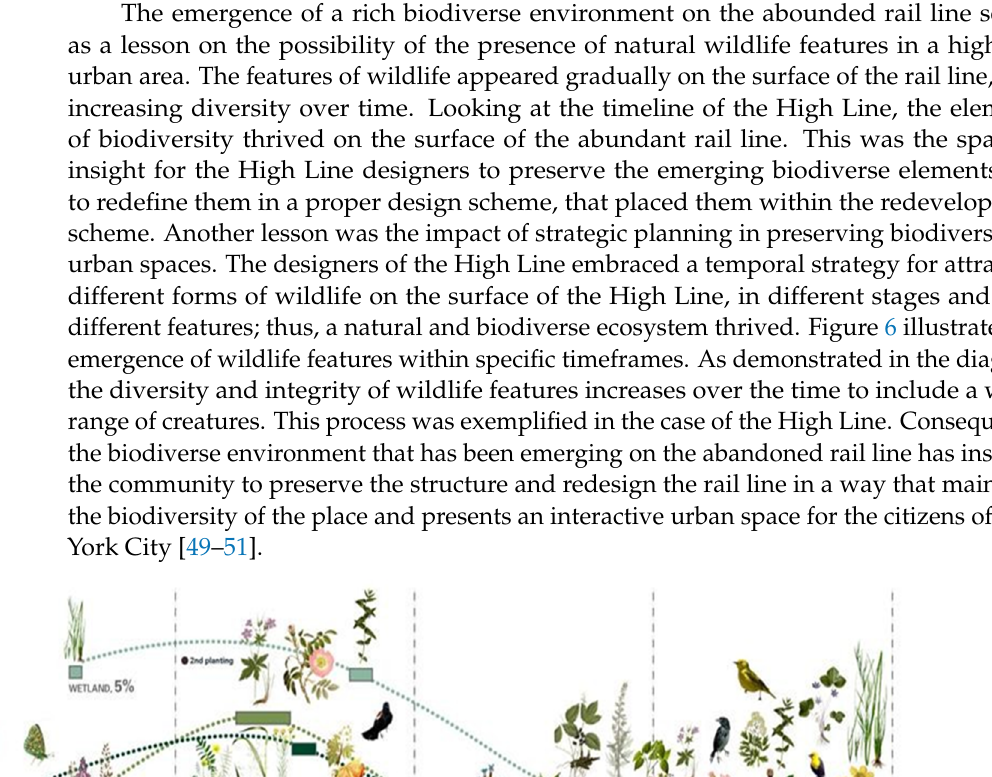
Figure 7. The High Line: ( A ) cross-section of the main pathway; ( B ) cross-section of a multi-level zone. Reprinted from ref. [50].